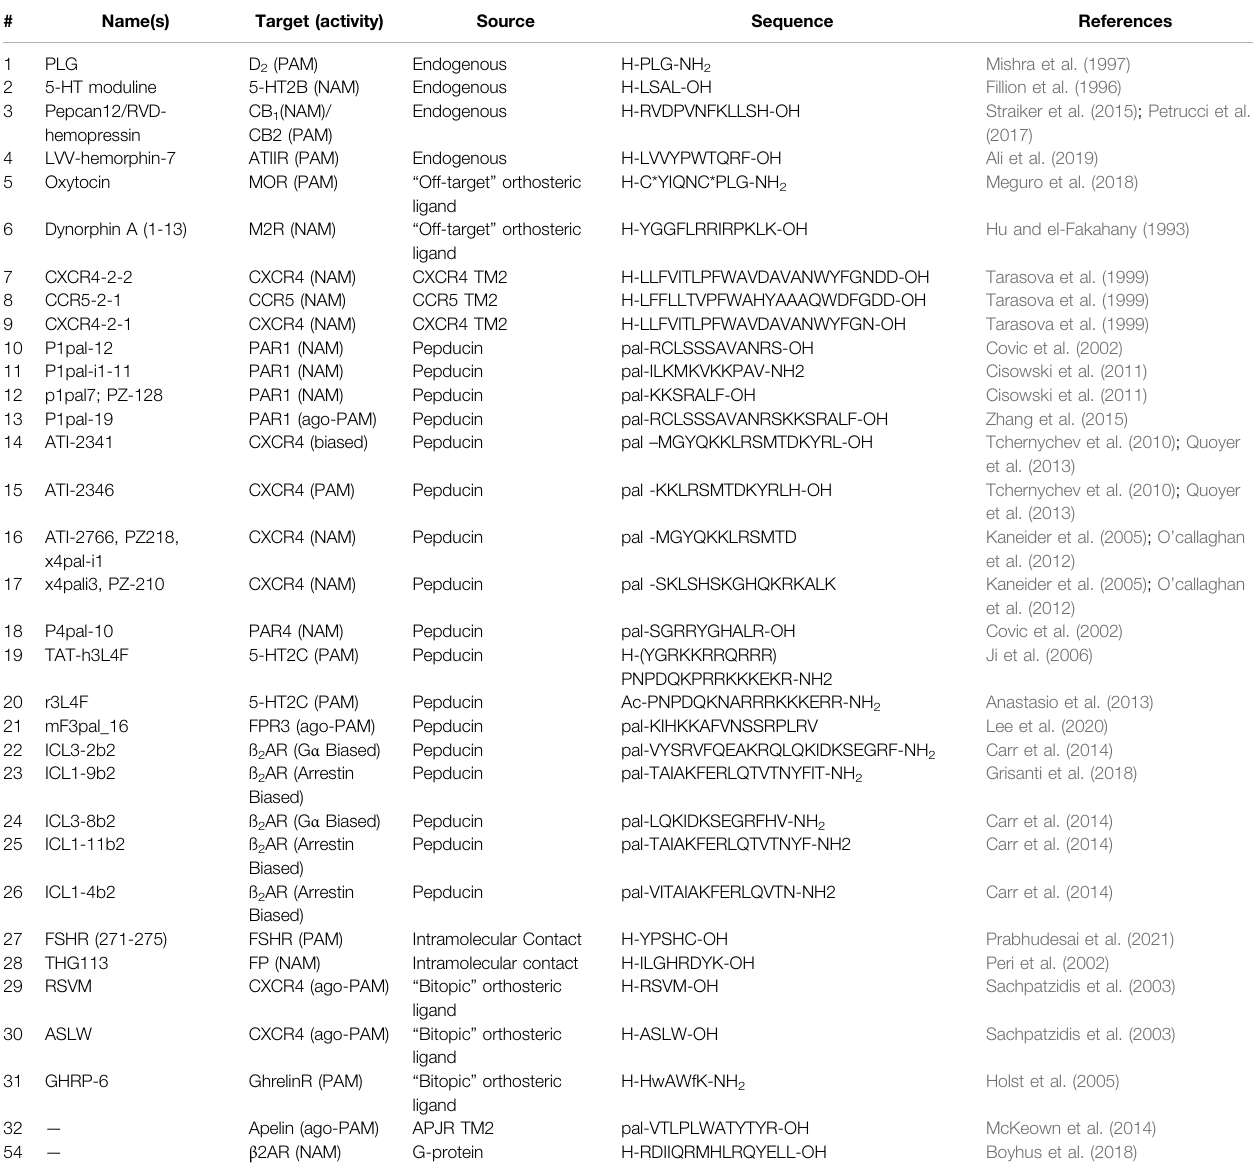
TABLE 2 | Sequences of linear peptide